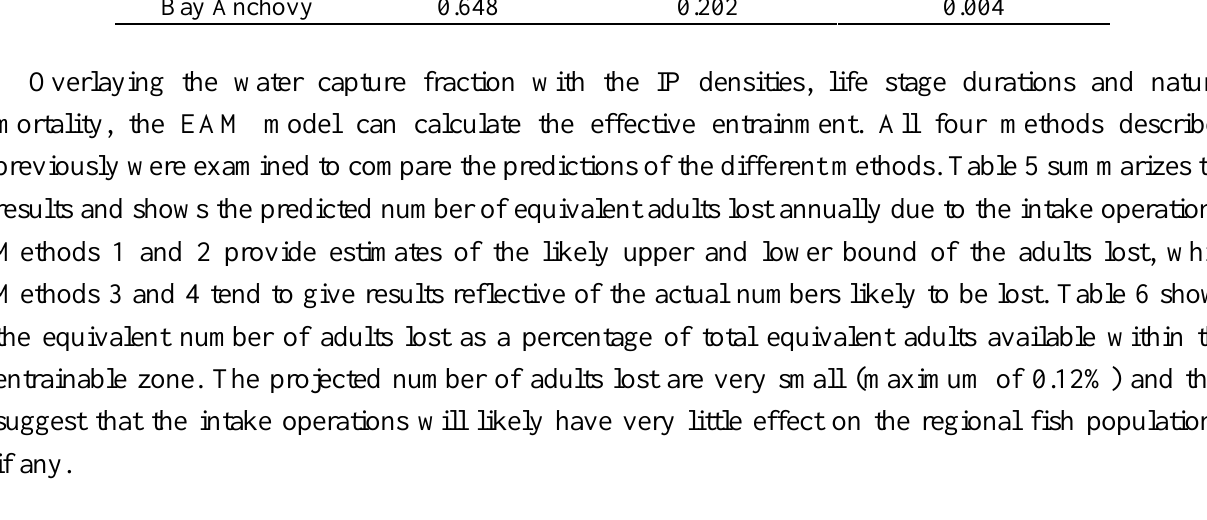
Table 5. Total number of equivalent adults lost annually during flood and ebb condition ballast water intake operations using the four equivalent adult methods available in